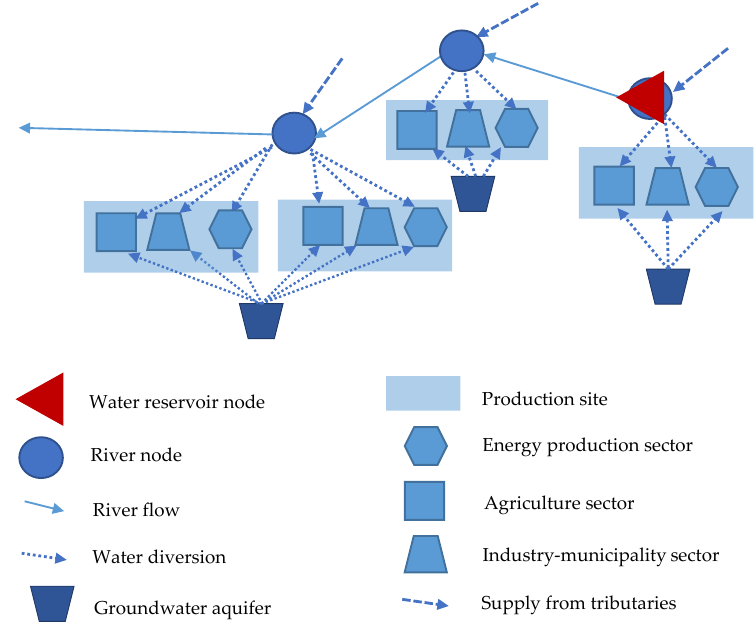
Scheme 1. The sample river node network scheme of the system-wide economic-water-energy model